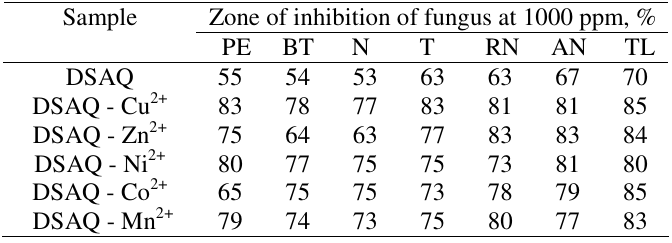
Table 3. Antifungal activity of DSAQ ligand and its metal